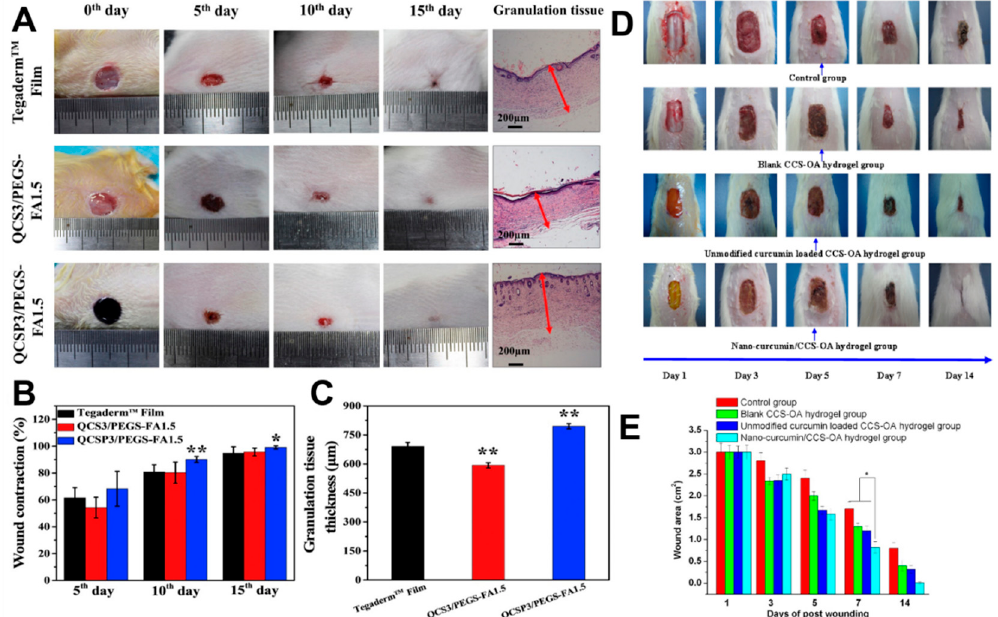
Figure 8. ( A ) Photographs of wounds at the 0th, 5th, 10th, and 15th day, and granulation tissue on the 15th day for commercial film dressings (Tegaderm™), hydrogel QCS/PEGS-FA, and hydrogel QCSP/PEGS-FA. ( B ) Wound contraction for the three groups. ( C ) Granulation tissue thickness for the three groups on the 15th day. Reprinted with permission [34] . © 2017, Elsevier Ltd. (Amsterdam, Netherlands). ( D ) Photographs of wound treated over 14 days with saline solution, blank CCS-OA